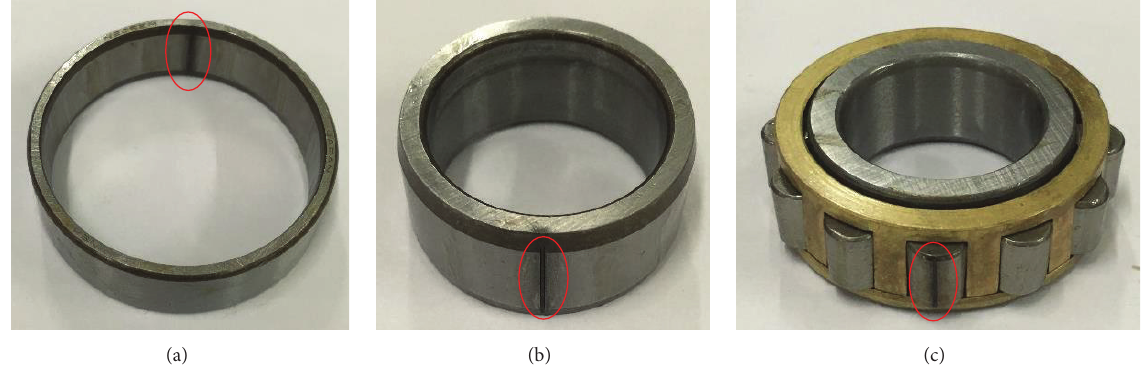
Figure 4: (a) Outer-race fault, (b) inner-race fault, and (c) rolling-element fault.